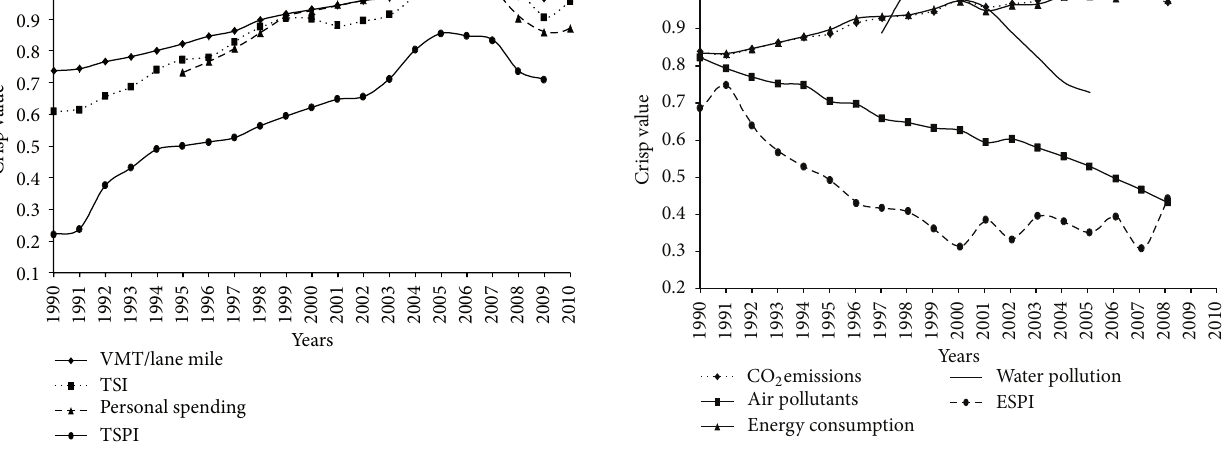
Figure 2: Historical Trend of Transportation System Performance Index and its Performance Measures.